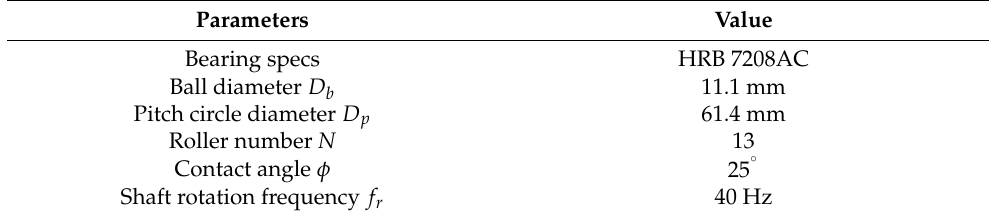
Table 4. Parameters of the gearbox.